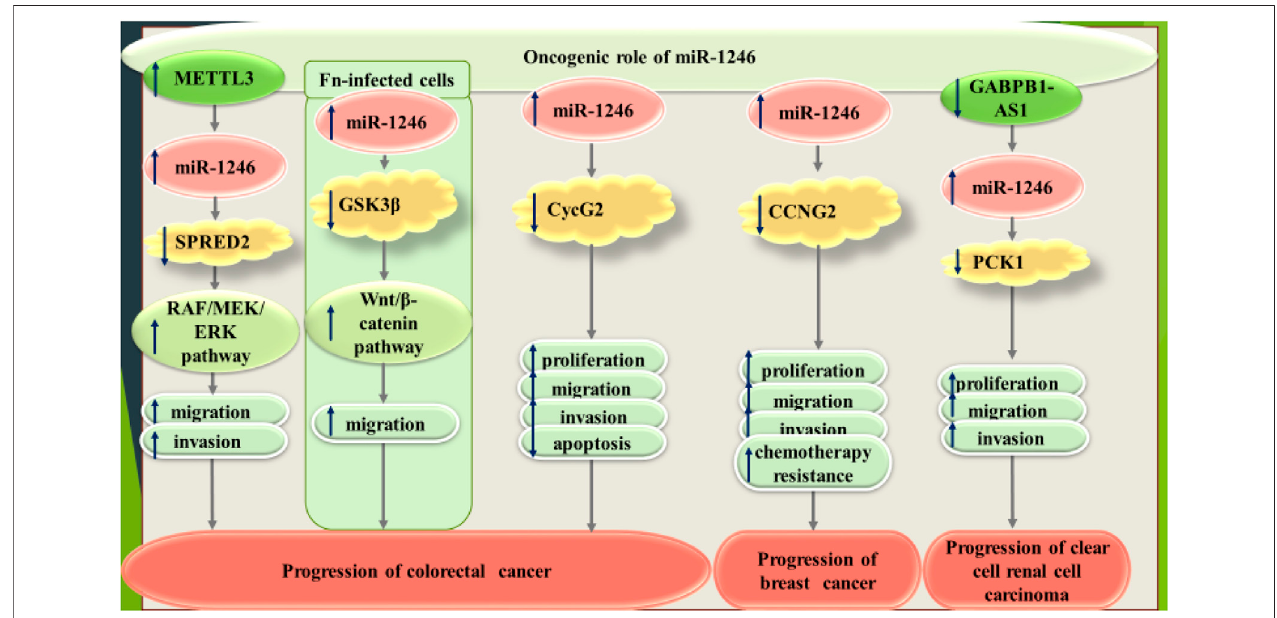
FIGURE 1 | Oncogenic role of miR-1246 in colorectal, breast and renal